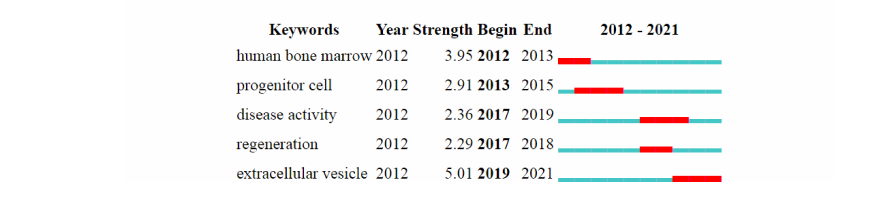
FIGURE 9 Top 5 keywords with the strong citation bursts. The red bar indicates high citations in that